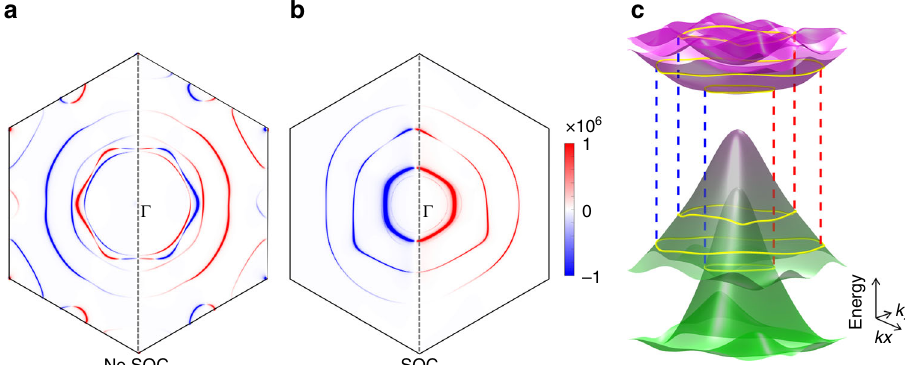
Fig. 3 a , b Distribution of the photoconductivity σ x xx in the fi rst Brillouin zone. Without including the spin-orbit coupling (SOC), the k to − k symmetry appears while fi nite SOC breaks such a symmetry. The ring-like shape indicates the resonant optical transition between valence ( E l ) and conduction ( E n ) bands by the selection rule E n − E l = ħ ω (1.2 eV). c Transitions from top two valence bands to the bottom two conduction bands. The yellow rings indicate the transition paths and correspond to the large- σ x xx -amplitude rings in (